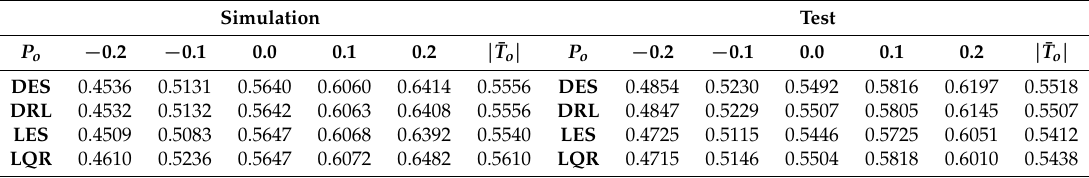
Table 6. Minor loop gain for the microgrid